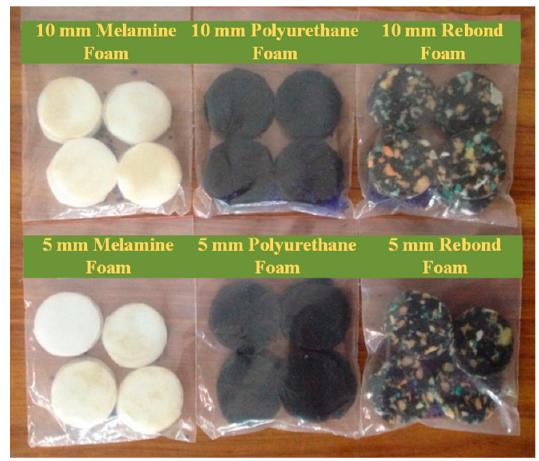
Figure 9. Open cell foam specimens used in lightning impulse and disruptive discharge experimentation.